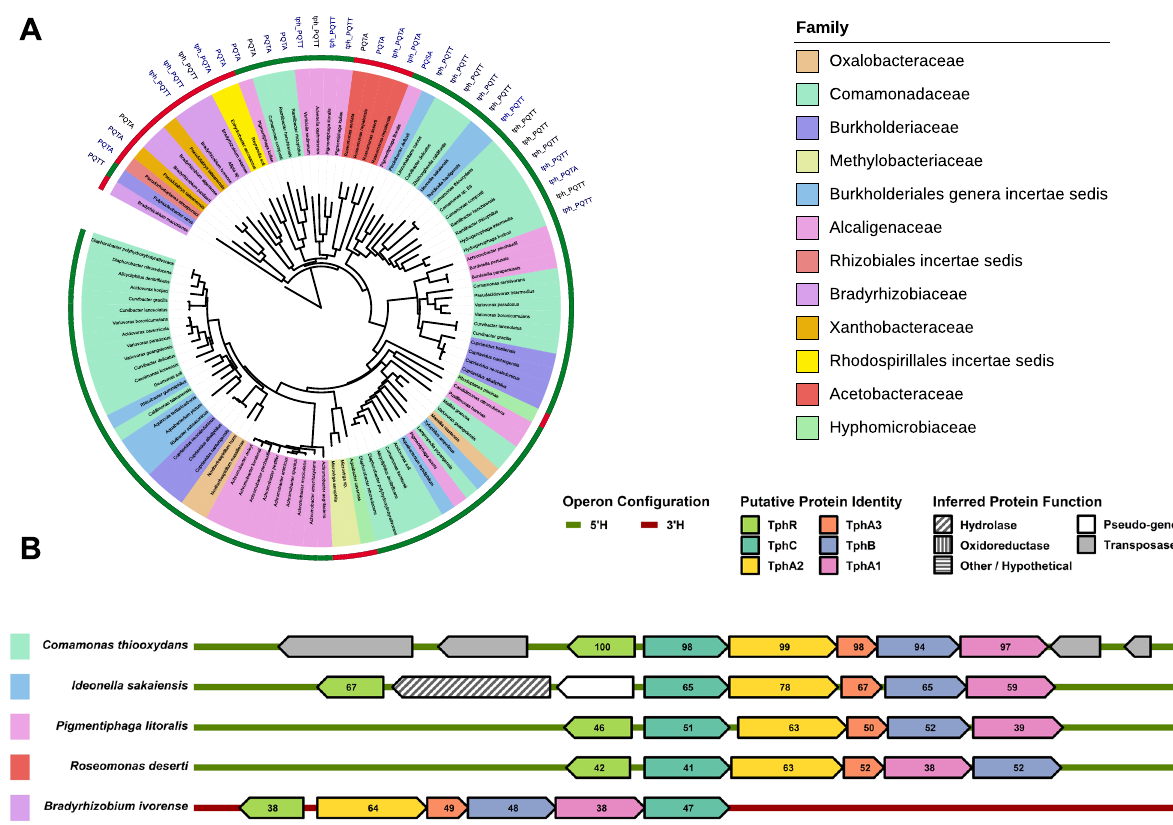
Fig. 7 Anotated phylogenetic tree of TphC and con fi guration of putative tph -like operons. A Phylogenetic tree of TphC constructed by retrieving, aligning and displaying sequences (using BLAST-P, Clustal Omega and iTOL respectively). Species names are coloured by taxonomic family ( n = 12) and taxonomic class is shown by a coloured outer ring ( α -proteobacteria (red) and β -proteobacteria (green). Genomic loci proposed to be tph -operon homologues are anotated (tph). Additionally, the amino acids (and their homologue equivalent) directly involved in ligand binding within the TphC-TPA are labelled, where P86, Q150, T155, and T242 (or A242) are labelled as PQTT (or PQTA). B Schematic diagram of the operon con fi guration for a selection of putative tph -like operons. Taxonomic family is shown by coloured boxes to the left of the operon. The values inside the genes indicate the percentage similarity of the encoded protein to the corresponding protein in Comamonas sp. strain E6. These operons show a range of alternative features, such as the presence of genes encoding transposases ( Comamonas thiooxidans ), a hydrolase ( Ideonella sakaiensis ), and alternative operon architectures ( Roseomonas deserti and Bradyrhizobium ivorense